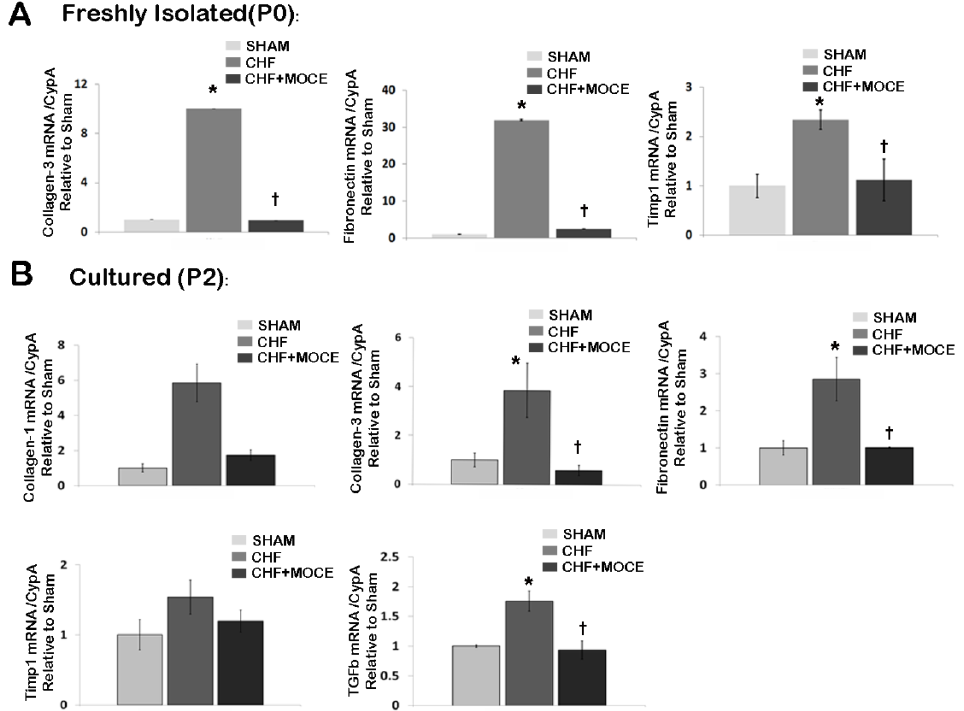
Figure 5. Mocetinostat reduced expression of ECM-related genes in endogenous cardiac fibroblasts. ( A ) Gene expression of collagen-3, fibronectin, Timp1 were measured with real-time PCR in CD90 + cardiac fibroblasts isolated from untreated and Mocetinostat-treated CHF hearts at P0 without culturing in in vitro ; ( B ) Gene expressions of collagen-3, fibronectin, and TGFβ were measured with real-time PCR in cultured (P2) CD90 + cardiac fibroblasts isolated from untreated and Mocetinostat-treated CHF hearts. Error bars indicate SE. ( n = 5); * , p < 0.05 compared to shams; †, p < 0.05 compared to untreated CHF; CHF, congestive heart failure; MOCE,